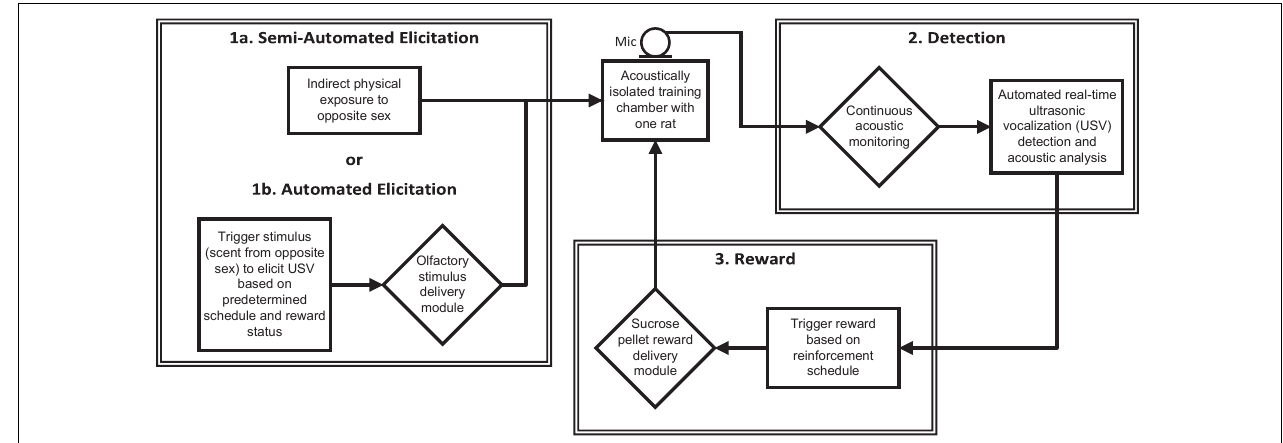
FIGURE 2 | Diagram of the semi-automated ultrasonic vocalization (USV) training procedure indicating the equipment (diamonds) and processes (rectangles) involved in the elicitation, detection, and reward of USVs.